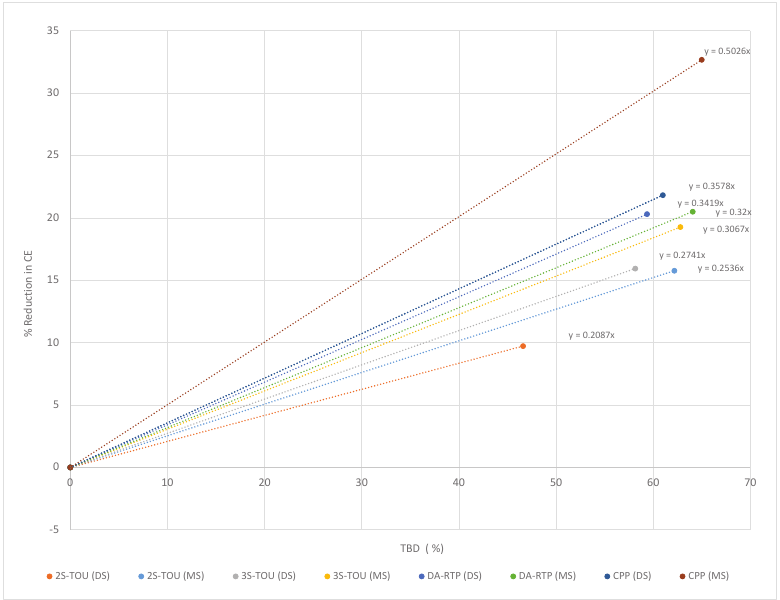
Figure 18. Trade-offs between CE and TBD for PDDR-based HEMS. Table 6. Performance metrics of DWS-PSO-based algorithm for PDDR-based